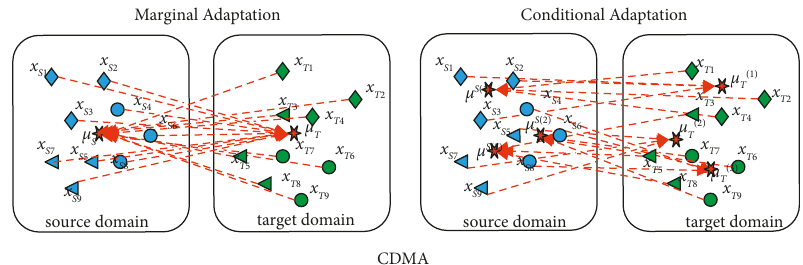
Figure 2: An illustration of